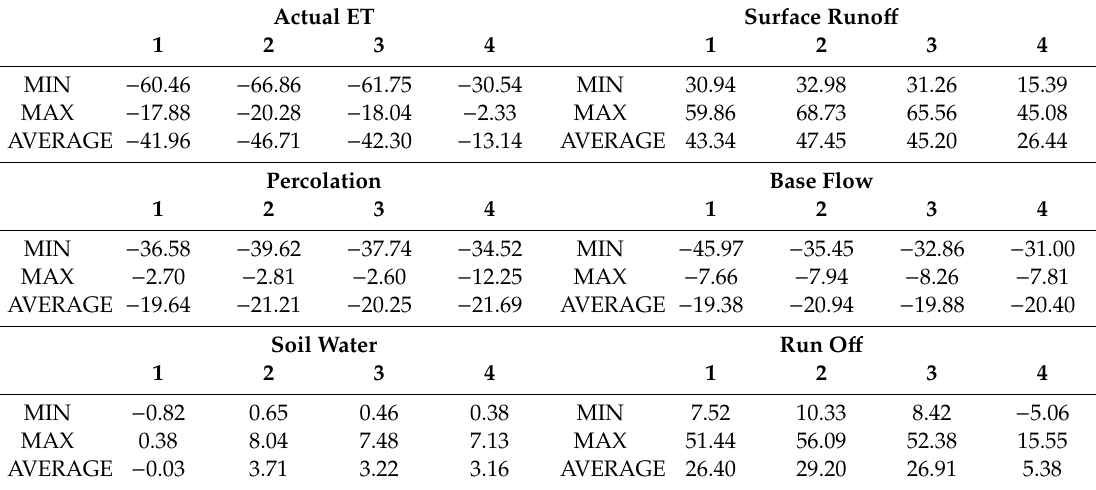
Table 8. Statistics of di ff erences in average annual actual ET, percolation, soil water, surface runo ff , base flow and runo ff values as a result of changing land